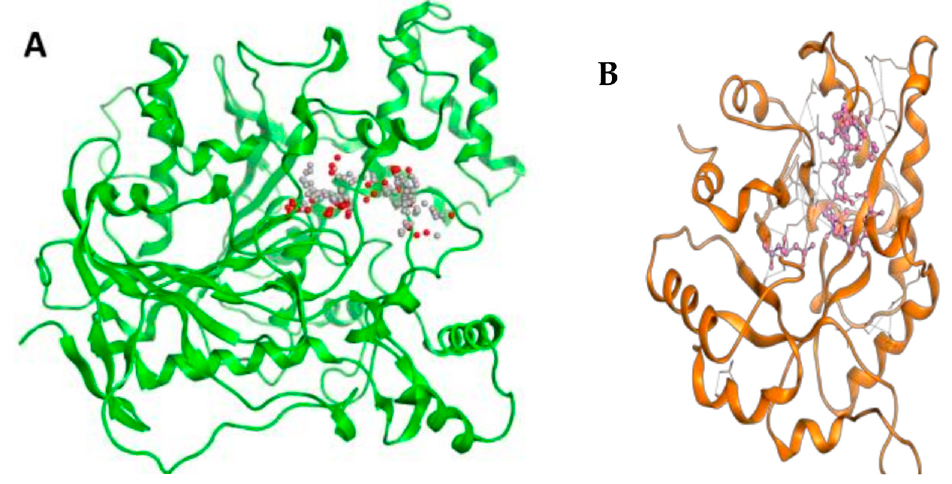
Figure 4. ( A ) RmAChE1 3D structure where active sites are represented by small red and grey dots and ( B ) RmTIM’s 3D structure where the colored portion in center shows active sites.